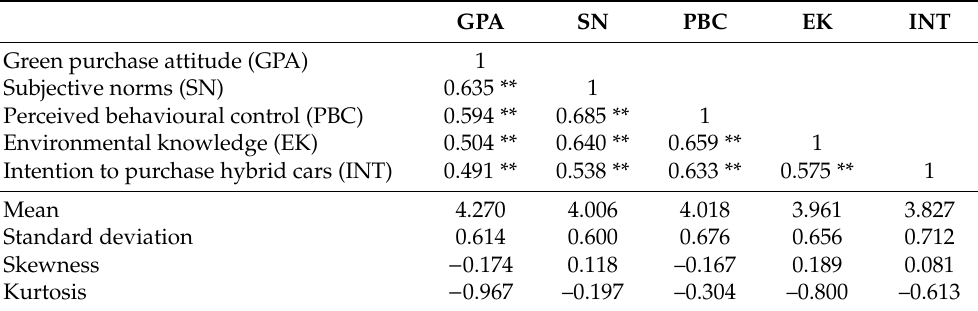
Table 4. Inter-construct correlations.